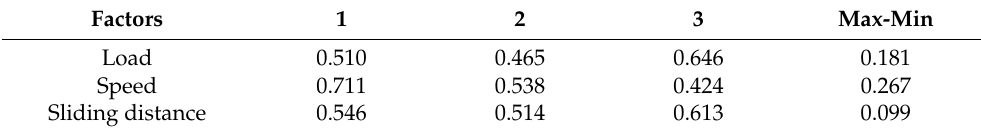
Table 5. Effects of grey rational grade with different factors and levels (1, 2, and